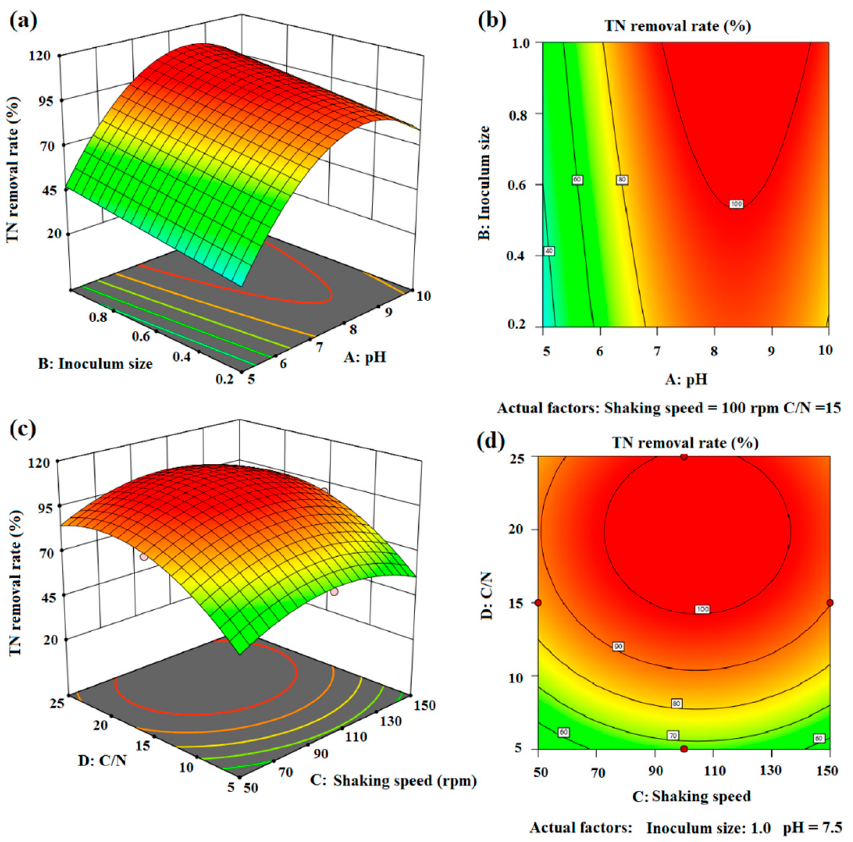
Figure 4. Response surface methodology results: ( a ) response surface and ( b ) contour plot of pH and inoculum size; ( c ) response surface and ( d ) contour plot of C/N ratio and shaking speed.